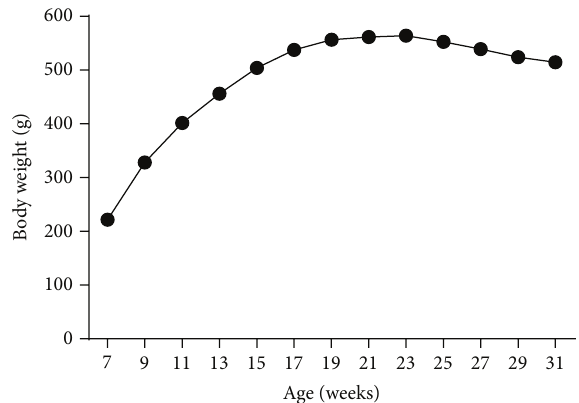
Figure 1: Body weight recorded biweekly throughout the study duration of 7- to 31-week-old ZDSD rats (mean ± SEM, 𝑛 = 23 , error bars included too small to